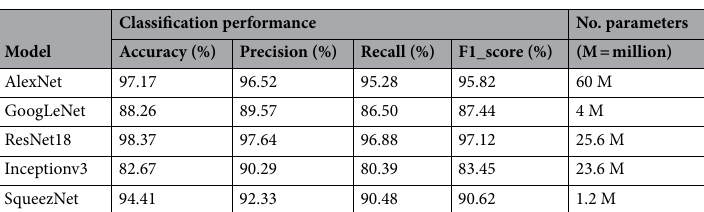
Table 1. Comparison of five deep neural network architectures.